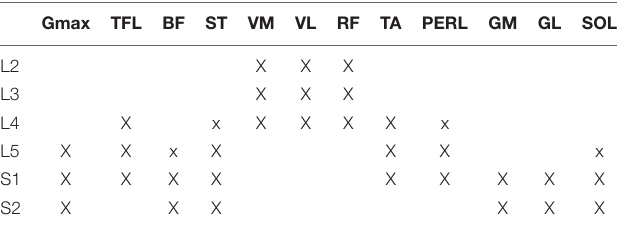
TABLE 1 | Innervation of the lower limb